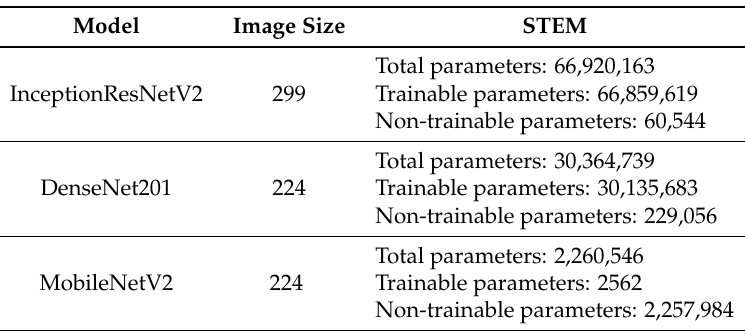
Table 6. Model and parameter details.